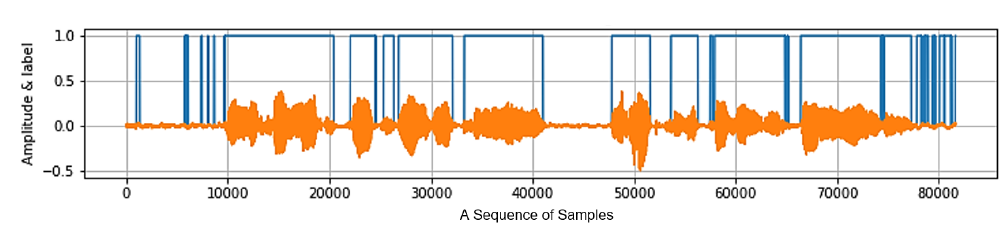
Figure 16. The result of energy-based filtering with fuzzy clustering.